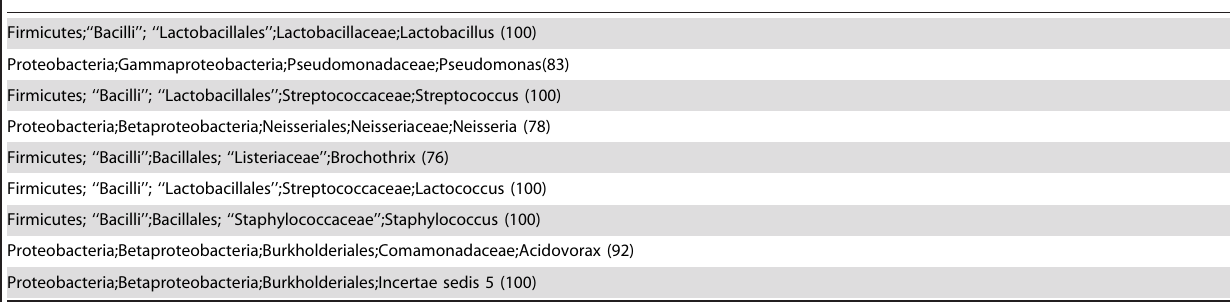
Table 2. Identified OTUs for hand surface bacteria data.